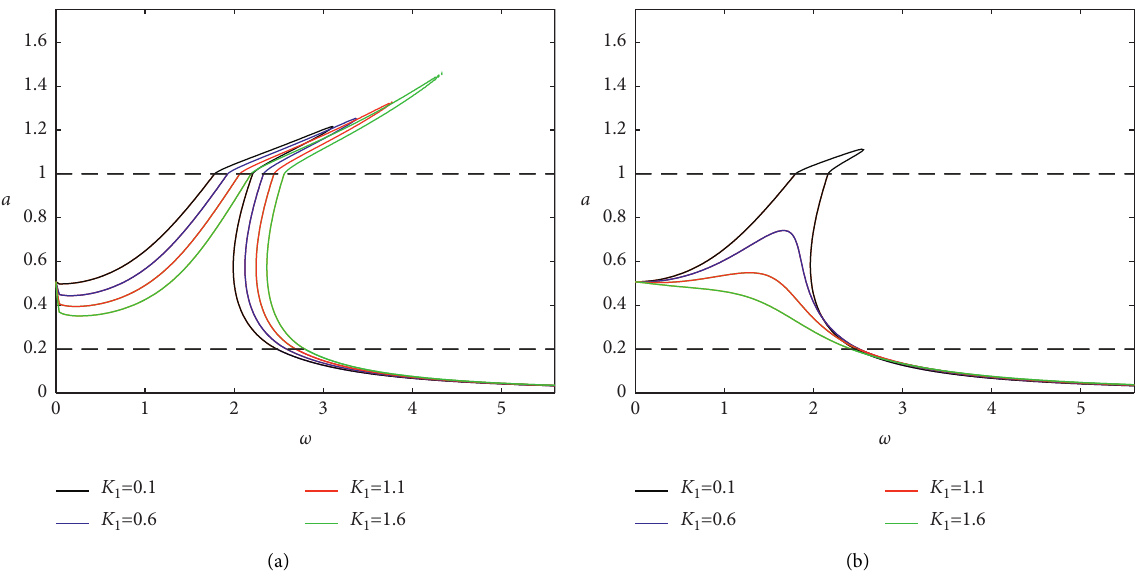
Figure 6: Amplitude frequency response curve with the coefficient of fractional differential term: (a) p � 0 . 1 and (b) p � 0 .